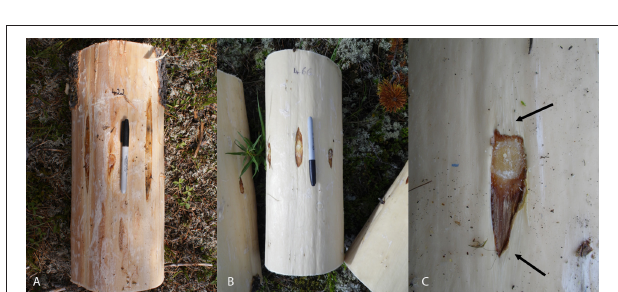
FIGURE 7 | Lesions in lodgepole pine: (A) lesion in 2010, (B) lesion in 2011, and (C) close up on lesion in 2011 showing new tissue growth ( ) into the lesion caused by fungal inoculation in 2010.